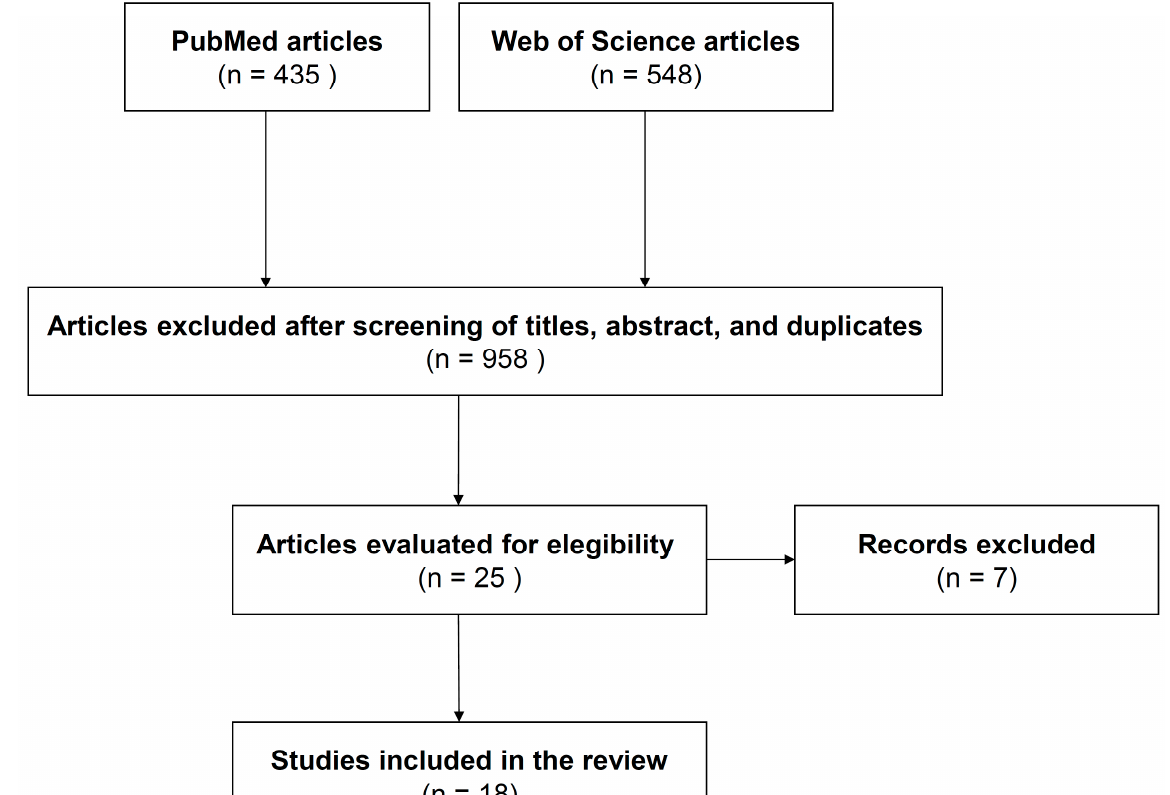
Figure 1. Flowchart of the study following PRISMA guidelines.